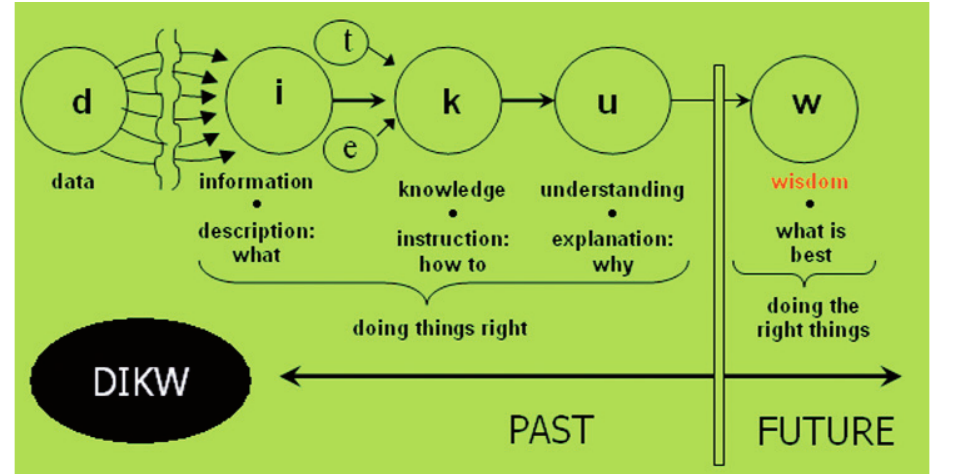
Figure 2. Flow diagram of the DIKW